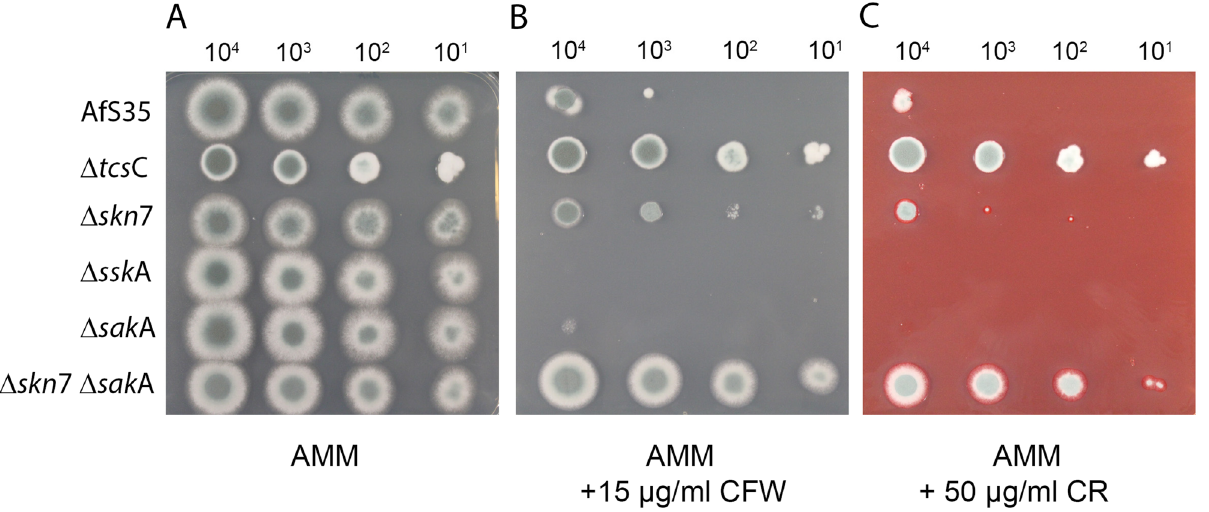
Figure 6. Growth of the HOG mutants in the presence of cell wall stressors. Drop dilution assays on AMM plates containing no stressor (panel A ), 15 µg/ml Calcofluor white (panel B ) or 50 µg/ml Congo red (panel C ). The plates were incubated for 48 h at 37 °C. The number of conidia applied per drop is indicated.